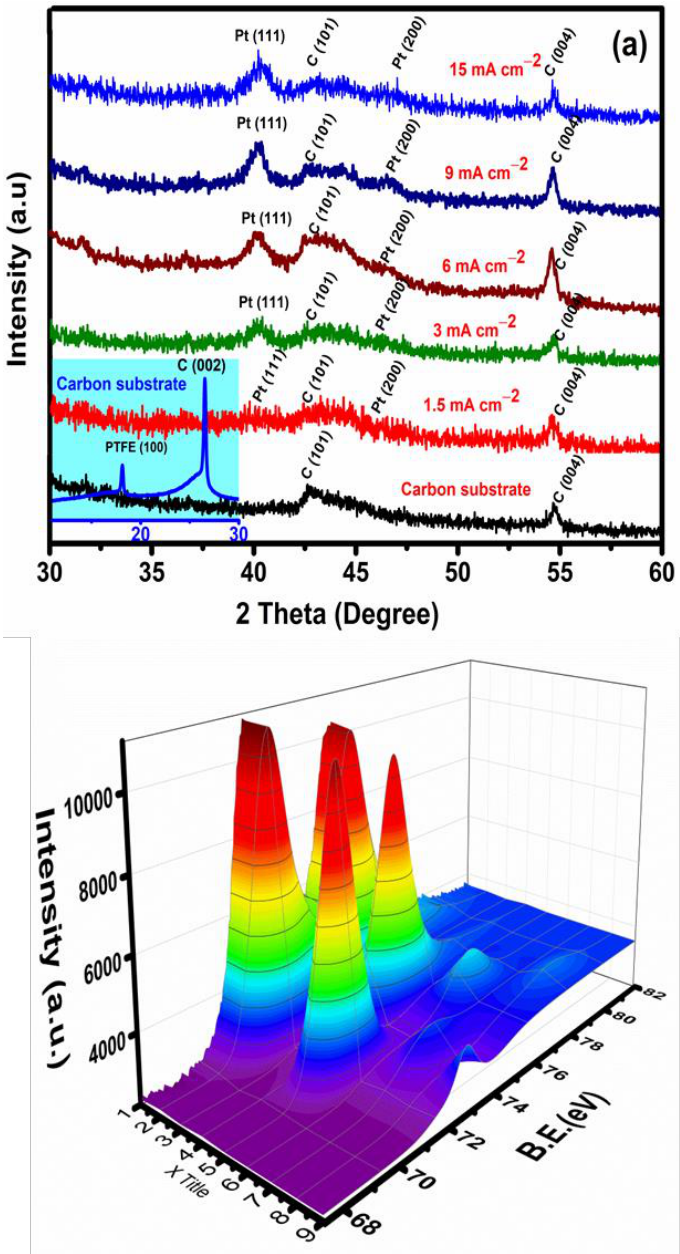
Figure 2. ( a ) Typical X-ray diffraction (XRD) pattern with Pt deposition of different current densities on a carbon substrate. (Note: The expended region between 10° and 30° indicated two different peaks due to carbon and PTFE observed for all samples). ( b ) 3D view XPS spectrum of Pt 4f binding energy orbital.